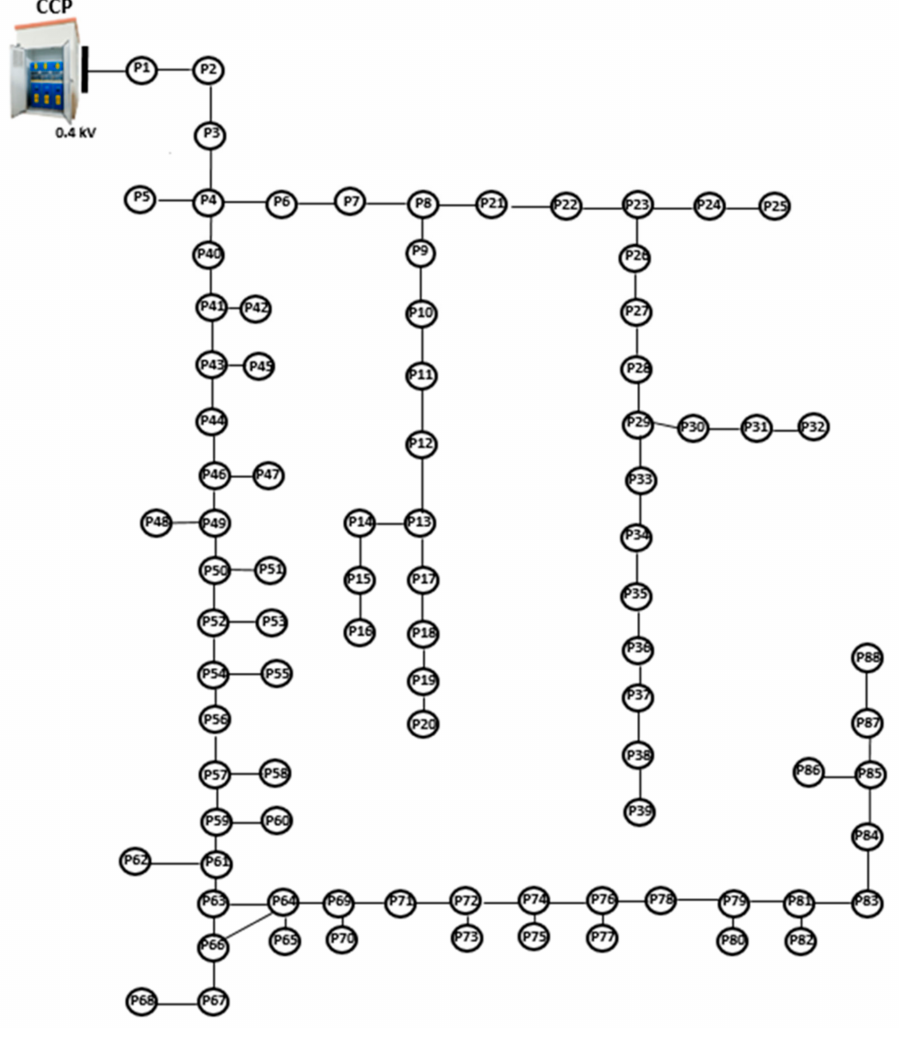
Figure 9. The topology of the test AEDN with 89 poles (including CCP) and 88